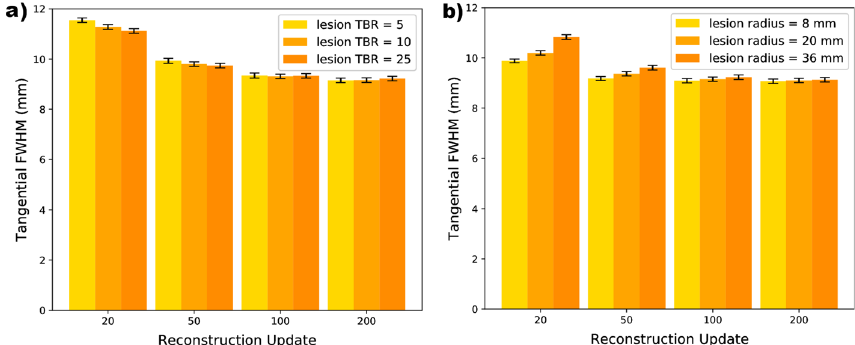
Fig. 4 Graphs demonstrating the effect of lesion parameters of a lesion contrast and b lesion size on tangential FWHM measurements for selected reconstruction updates in noise‑free images of the simple elliptical phantom. The point of measurement was in a lesion, 8 cm from the centre of the